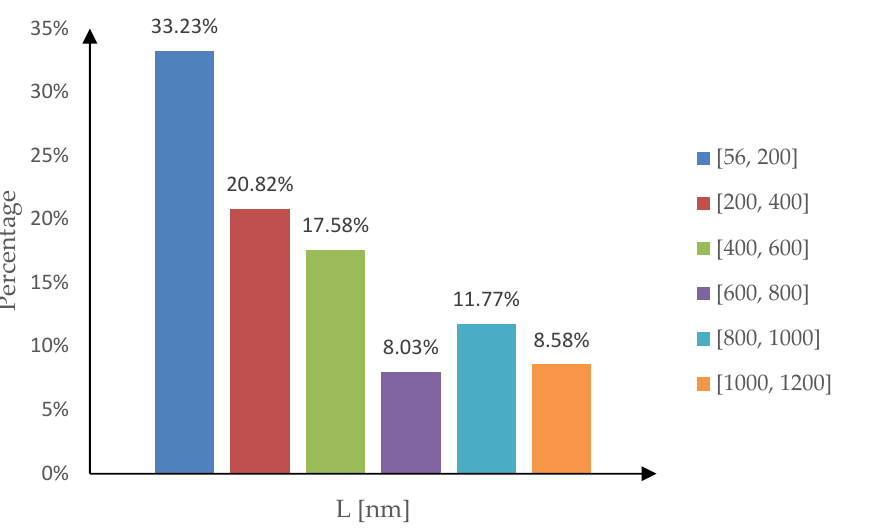
Figure 9. Gate length distribution of the test data with an RE greater than µ + 3 σ . The test data with an RE greater than µ + 3 σ accounted for 1.50% of all test data.